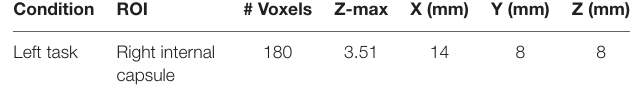
Frontiers in Human Neuroscience |